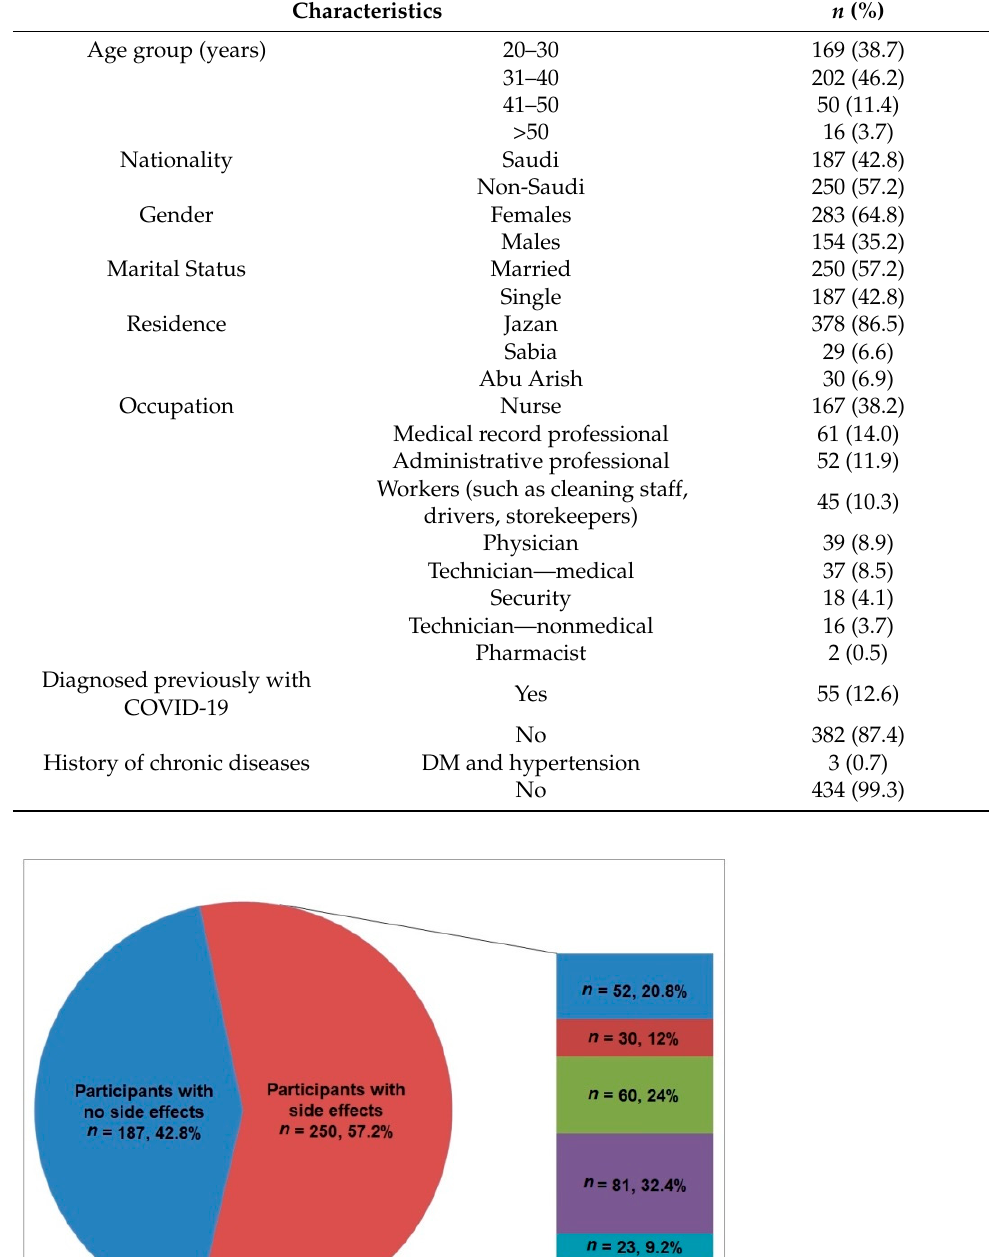
Table 1. General demographic and health characteristics of the participants ( n = 437).